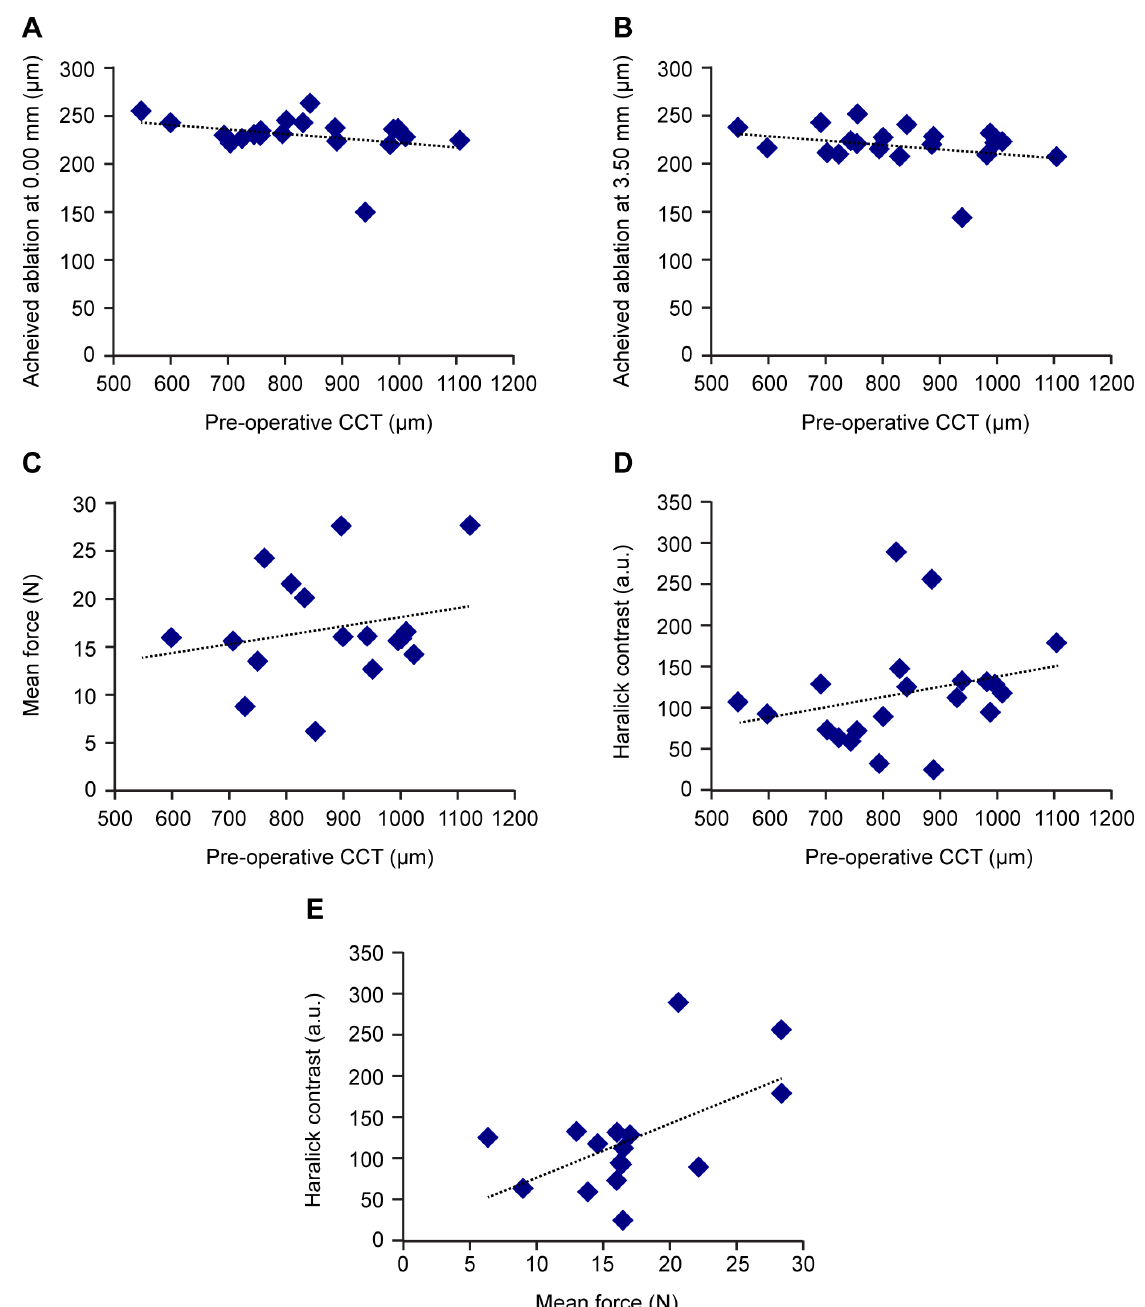
Figure 3. Quality of the laser cut. Effect of corneal hydration on the achieved ablation depth in the central and peripheral cornea (A and B), flap separability (C) and surface roughness (D). Surface roughness as a function of flap separability (E) is also